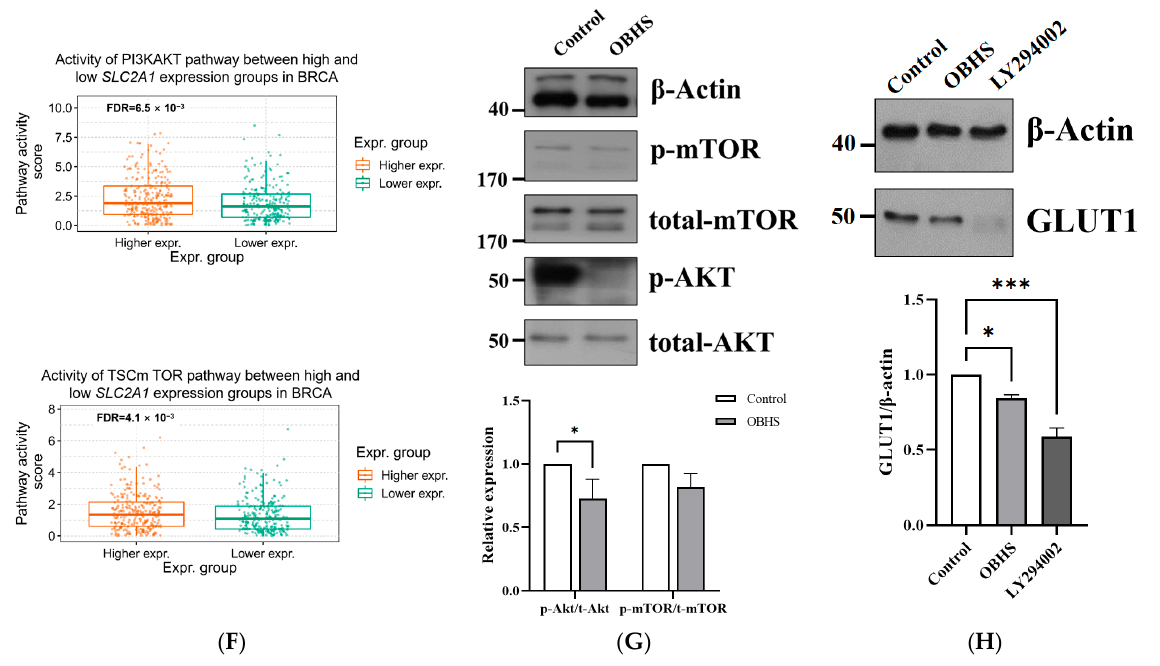
Figure 2. OBHS significantly inhibited glucometabolic via PI3K/Akt-GLUT1 pathway. MCF-7 cells were seeded at a density of 10 6 cells/well and treated with OBHS for 24 h. ( A ) Lactate concentration and ( B ) glucose uptake and glucose consumption were decreased by OBHS (10 µM, purple bars) in MCF-7 cells. ( C ) SLC2A1 mRNA expression was downregulated in 5 h OBHS-treated MCF-7 cells. ( D ) Protein levels of GLUT1 were decreased by OBHS for 24 h treatment. ( E ) GSCA summarized the percentage of breast cancer cells in which the mRNA expression level of the SLC2A1 gene had a potential effect on pathway activity. The activated signaling pathway is shown in the red font. * p ≤ 0.05 versus low SLC2A1 expression groups; # FDR ≤ 0.05 versus low SLC2A1 expression groups. ( F ) Activities of PI3K/Akt and mTOR pathways between high- and low- SLC2A1 expression groups in BRCA. ( G , H ) Immunoblot of signaling-pathway-related gene expression using the indicated antibodies in MCF-7 cells treated with OBHS and LY294002. Data are expressed as the mean ± SEM. * p < 0.05 versus control; ** p < 0.01 versus control; *** p < 0.001 versus control.